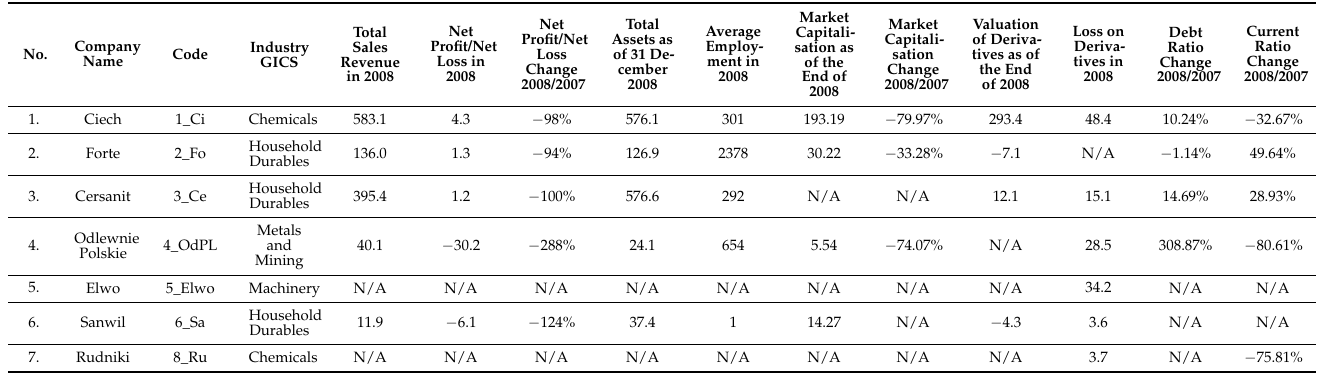
Table A1. Selected financial data of companies affected by the debacle identified in the research (in million